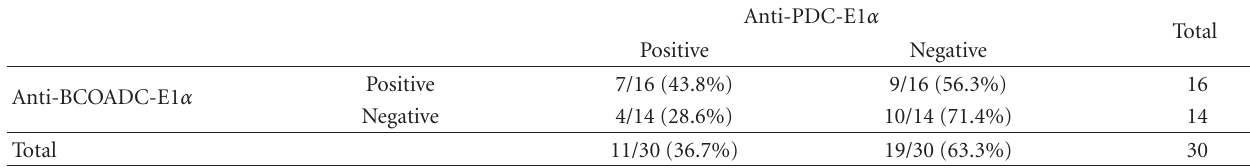
Table 4: Number of patients with and without anti-BCOADC-E1 α and anti-PDC-E1 α antibodies.